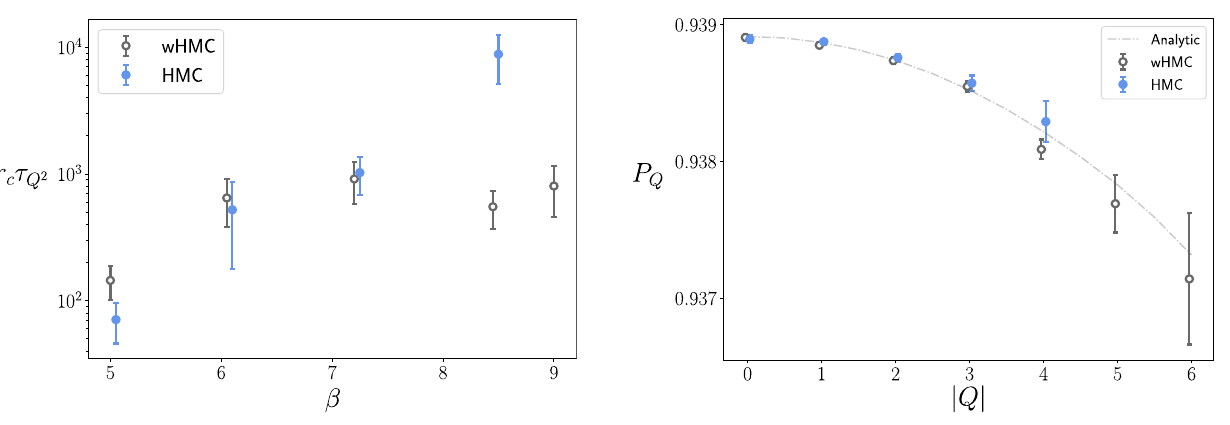
Fig. 12 P Q versus Q at β = 8 . 45 for wHMC and HMC versus the analytical result